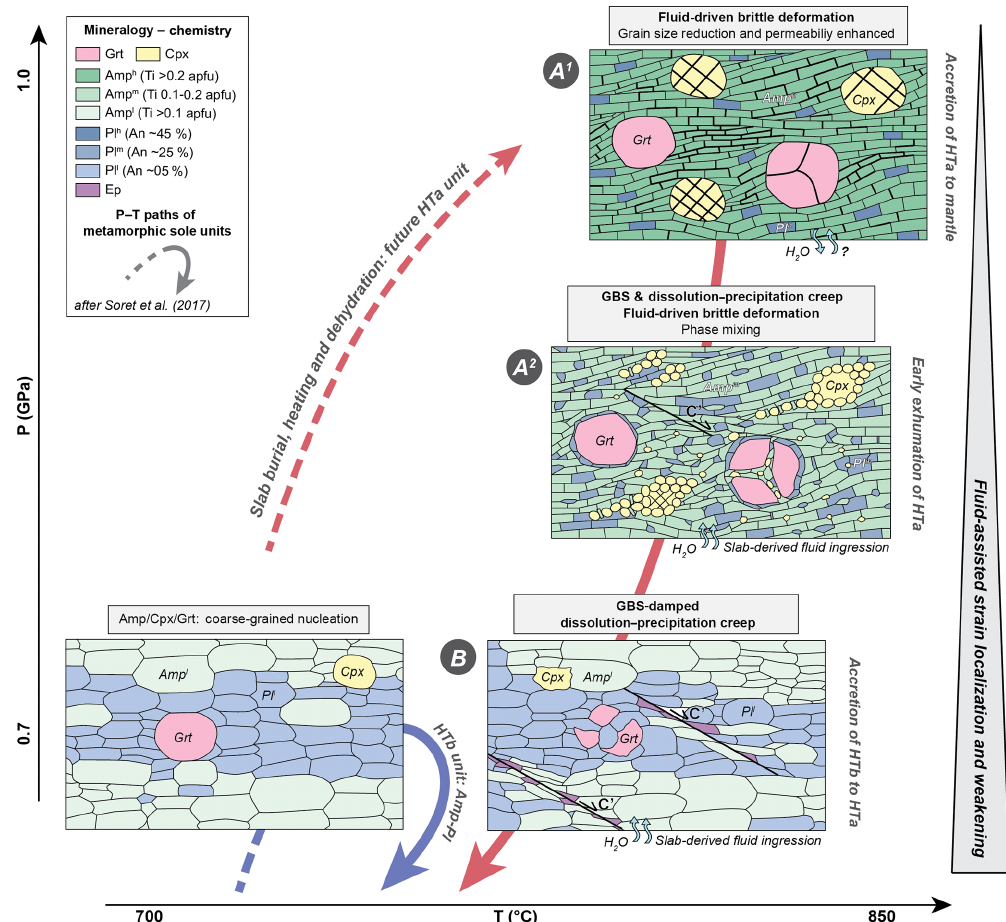
Figure 13. Model evolution at the grain scale of the deformation of the amphibolite of the Semail metamorphic sole (as a witness of that of the top of the slab crust during subduction infancy) during the formation, accretion and early exhumation to the peridotite during the subduction